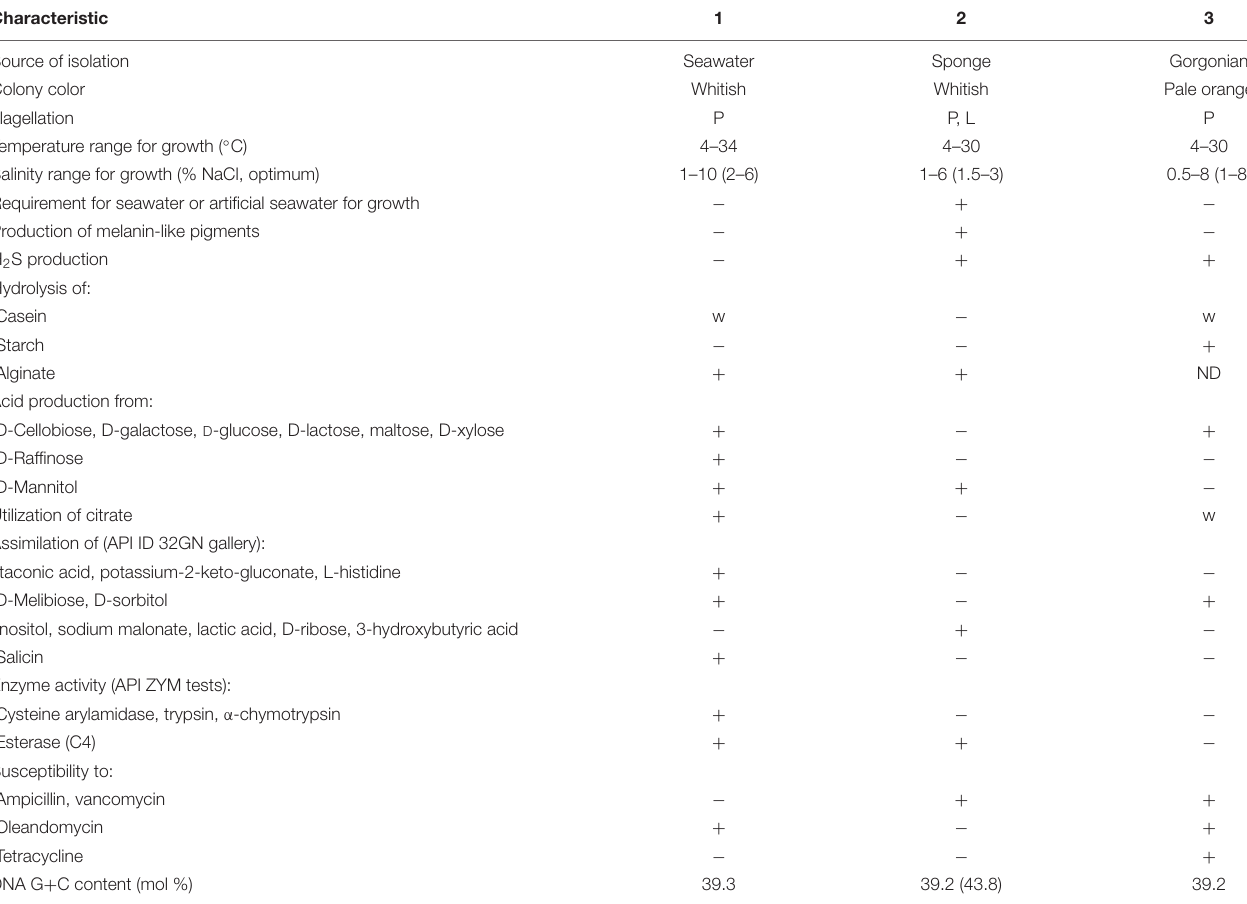
TABLE 1 | Phenotypic characteristics of the strain 16-SW-7 and the closest relatives of the genus Pseudoalteromonas . Characteristic 1 2 Source of isolation Seawater Sponge Gorgonian Colony color Whitish Whitish Pale orange Flagellation P P, L P Temperature range for growth ( ◦